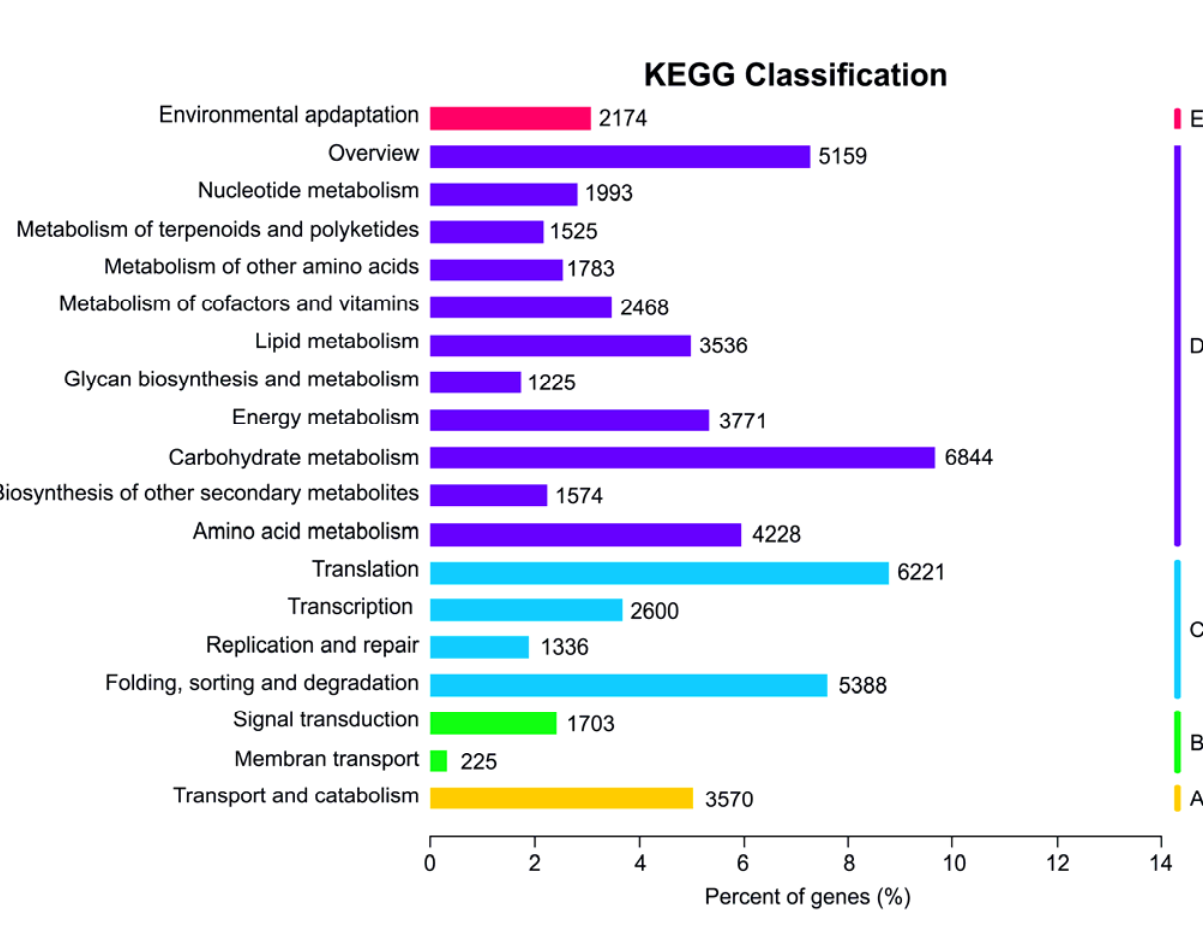
Figure 2. KEGG functional classifications.